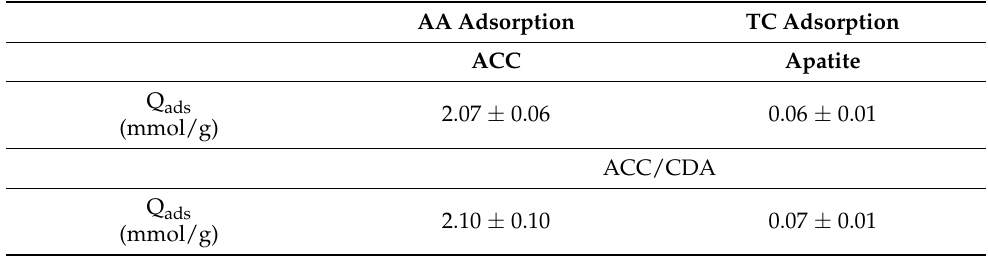
Table 4. Comparison of TC and AA adsorbed amounts on ACC, biomimetic apatite powder and the composite ACC/CDA material (following protocol 3 as depicted in Figure 10).